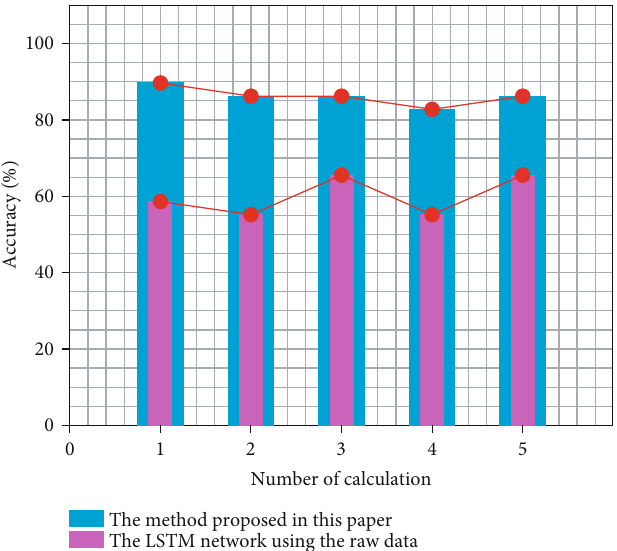
Figure 6: The accuracy of the LSTM network and the method proposed in this paper for training on the same dataset.